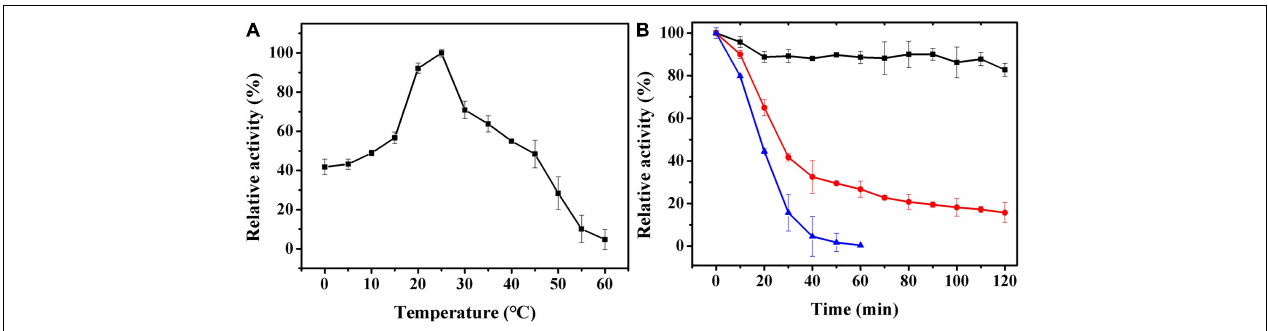
FIGURE 6 | (A) The optimal temperature of Ps-Grx3 was determined by measuring its activity at temperatures from 0 to 60 ◦ C. (B) The effect of temperatures on the stability of the purified Ps-Grx3. The enzyme was incubated at 30 ( (cid:4) ), 40 (